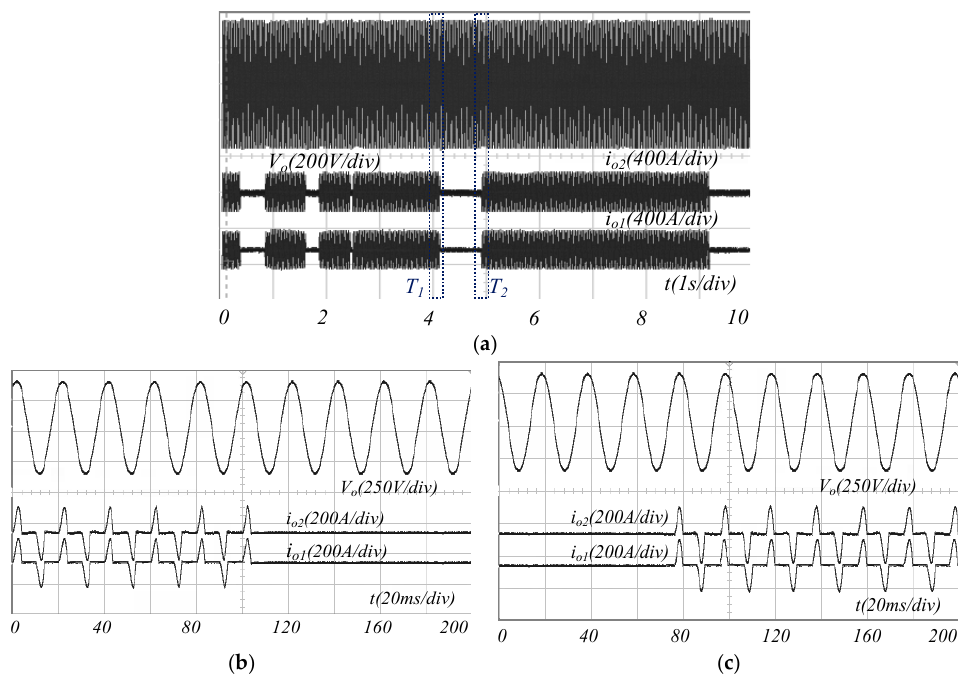
Figure 13. Experimental waveforms of current and voltage in dynamic process of proposed method in experiment II: ( a ) with repetitive step change of non-linear load; ( b ) during T 1 ; ( c ) during T 2 .